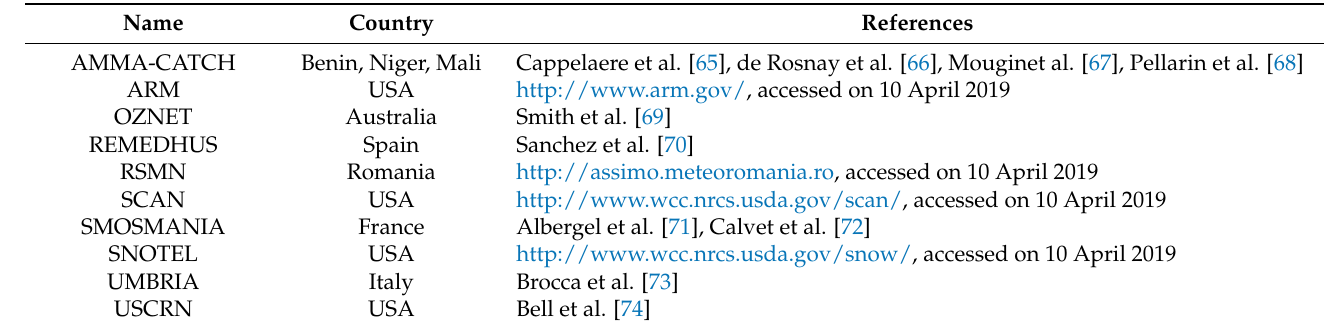
Table 1. Networks from the ISMN used in the